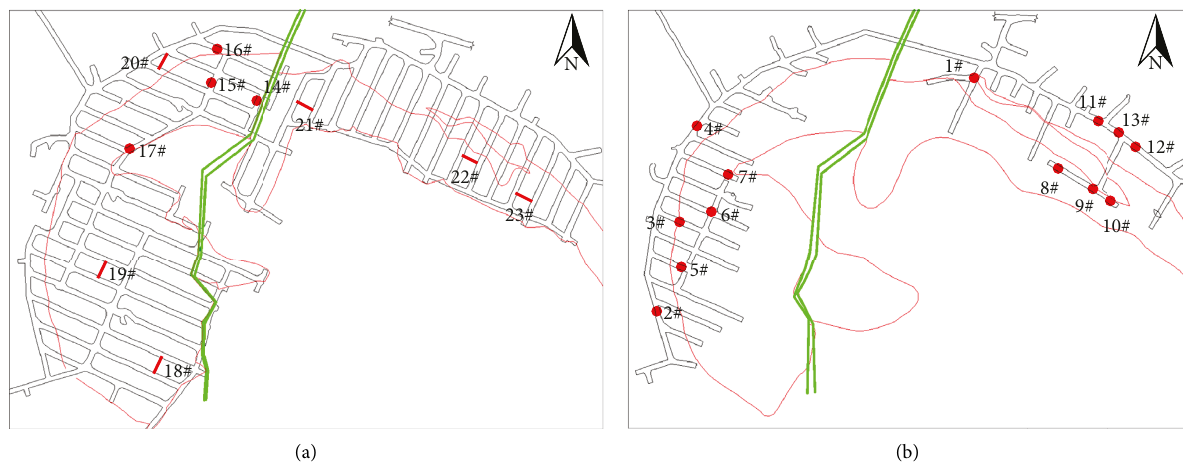
Figure 5: EDZ test position on the roof or sidewall. (a) − 218 m sublevel. (b) − 236m